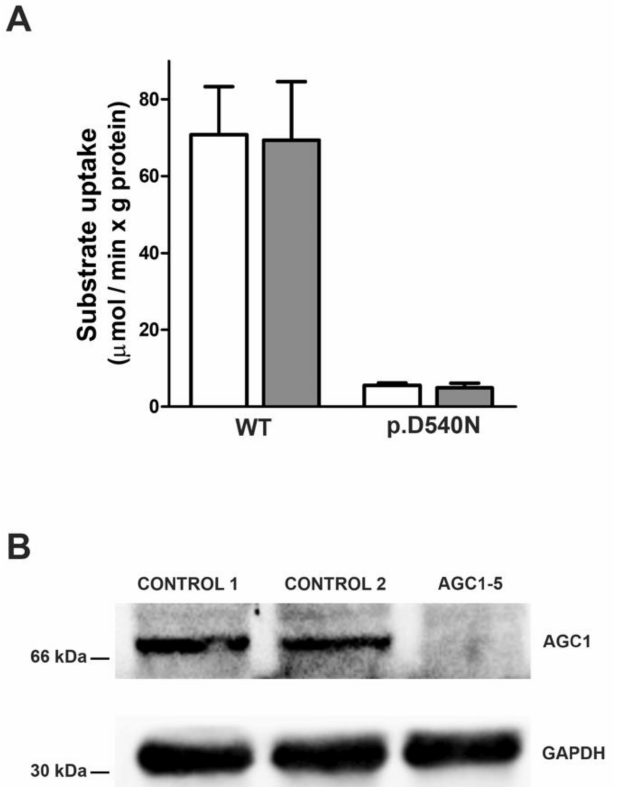
Figure 5. Functional validation of AGC1 variants in AGC1-2/3 and AGC1-5. ( A ) Transport assays of wild-type and p.D540N AGC1 variant in liposomes. Wild type (WT) and the p.D540N AGC1 variant of AGC1-2 and AGC1-3 patients were overexpressed in Escherichia coli , purified and reconsti- tuted in liposomes, as previously described [40]. The uptake rate of 14 C-glutamate (white bars) or 14 C-aspartate (grey bars) was measured by adding 1 mM of radiolabelled glutamate or aspartate to liposomes reconstituted with purified WT or p.D540N AGC1 and containing 20 mM of glutamate. Transport reaction was terminated after 1 min by adding 20 mM of pyridoxal 5 (cid:48) -phosphate and 20 mM batophenathroline. The means and SDs from three independent experiments are shown. ( B ) Expres- sion analysis of AGC1 in fibroblasts from unrelated healthy controls and AGC1-5 proband. 100 µ g of fibroblasts cultured at 37 ◦ C in a humidified atmosphere with 5% CO2 in high glucose DMEM (D6546 SIGMA) supplemented with 10% foetal bovine serum and glutamine 2 mM, were harvested at passage #3 and lysed for western blot analysis with an antibody against AGC1. Densitometry analysis revealed the absence of AGC1 in AGC1-5 cells in comparison with two unrelated healthy controls showing similar AGC1 expression. An antibody against GAPDH was used for protein expression normalisation. The full western blot analysis is provided in Supplementary Figure S1 (Supplementary